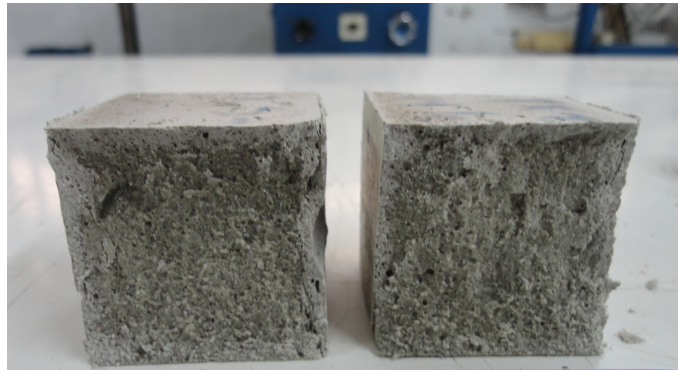
Figure 18. Section of 15% PX27 mortar probe